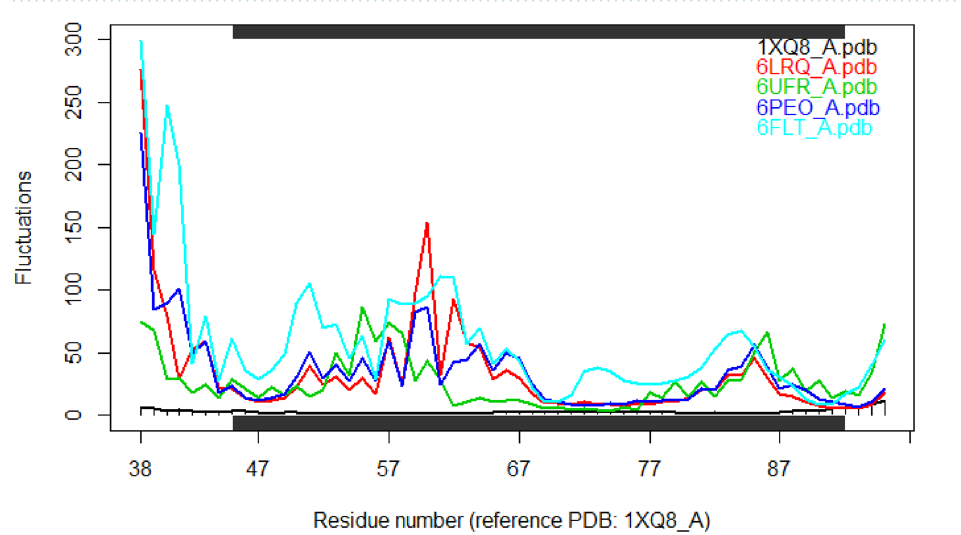
Figure 2. DI scores based on top DCA contacts, ( a ) The co-evolved residue patches at NAC domain. ( b ) A weighted network G DCA and corresponding color modules based on over all residual co-variation from DI score.